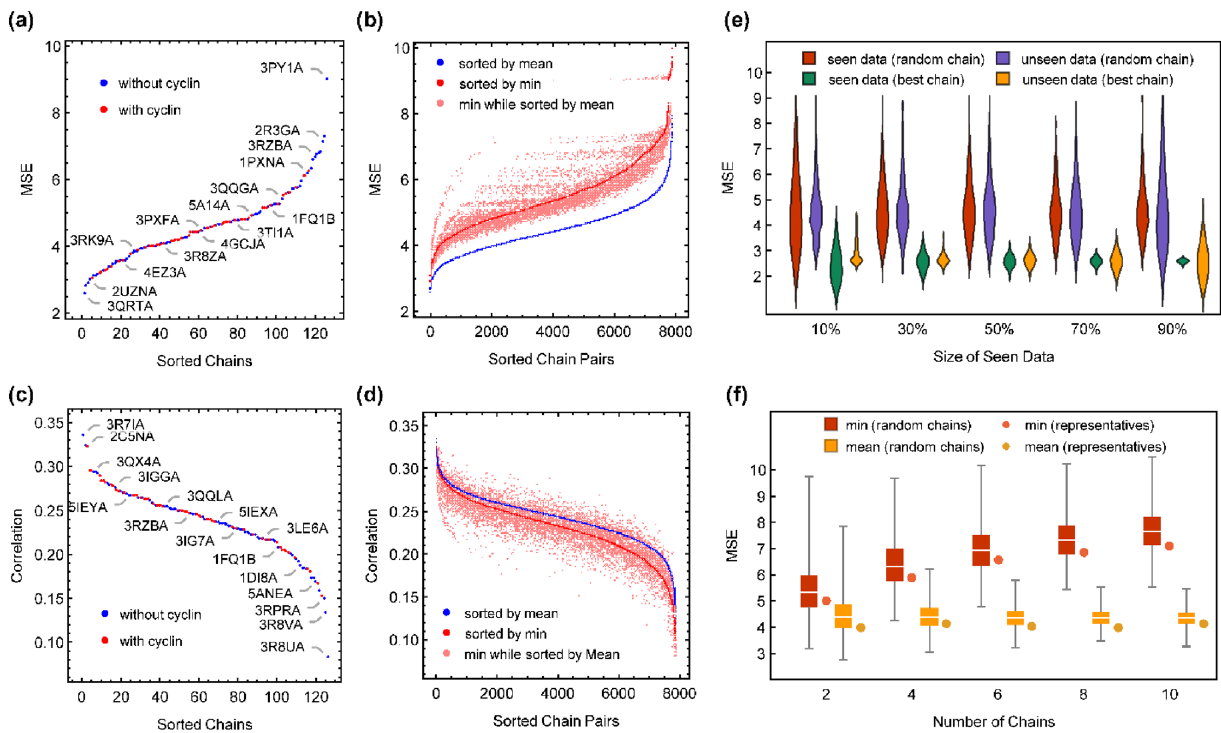
Figure 4. ( a ) MSE of docking predictions of all 126 chains of the non-redundant receptor ensemble. ( b ) MSE of all 7875 ensemble dockings to pairs of receptors. “min” and “mean” refer to using the minimum or average affinities of each ensemble. ( c , d ) Same as ( a ) and ( b ) for the Pearson’s correlation coefficient between docking predictions and experimental values. ( e ) Distribution of docking MSE upon selection of best receptor from a random fraction of data (seen data) and using it on the rest of data (unseen data) compared with docking MSE distribution for a randomly selected receptor applied to the same data. ( f ) Docking MSE values of ensembles of different size composed of representative receptors obtained from partitioning of curated receptor ensemble to different numbers of clusters compared to random ensembles of the same size. “min” and “mean” refer to using the minimum or average affinities of each